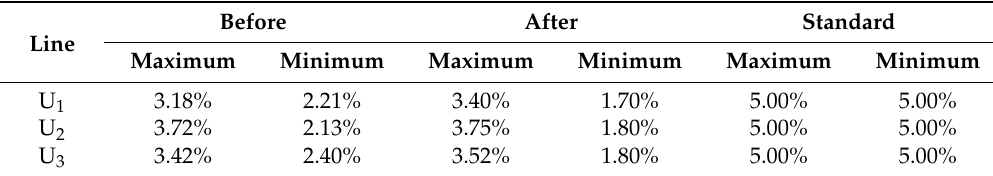
Table 6. Comparison of Total Voltage Harmonic Distortion (THD).